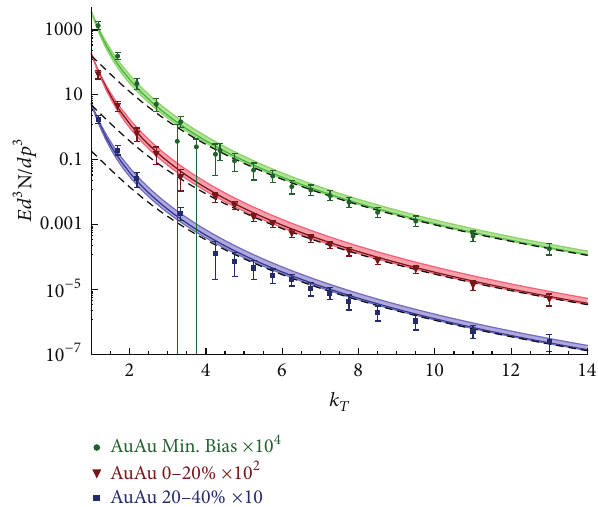
Figure 1: Comparison between the PHENIX photon data and the present model for three centrality bins [2]. The best fit corresponds to 𝛿 = 0.144 ± 0.0045 . The parameter 𝜆 controls the 𝑥 dependence of the saturation momentum with the best fit value 𝜆 = 0.29 ± 0.05 . For each of three color bands, the 𝜂 (or 𝛿 ) varies as 𝜂 = 6.65 ∓ 0.60 ( 𝛿 ≃ 0.144 ± 0.045 ) at 𝜆 = 0.29